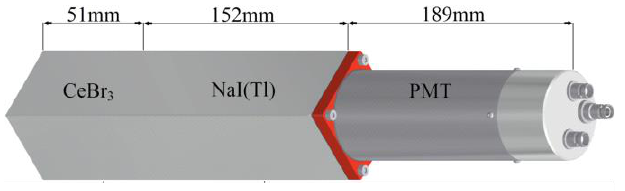
Fig. 3. CeBr 3 + NaI(Tl) phoswich scintillation detector. Dimensions of the crystals are 51x51x51 mm (CeBr 3 ) and 51x51x152 mm (NaI(Tl)).